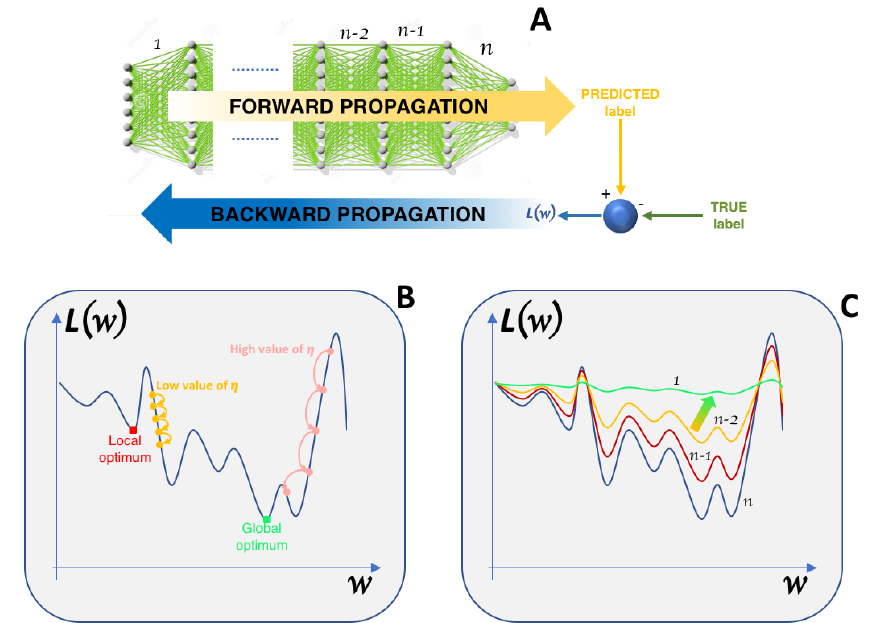
Figure 5. The Loss function and the backward propagating of its gradient. ( A ) The predicted label is compared with the true label for the current set of model weights θ w to compute the output error (also called a loss function) L ( θ w ) . ( B ) The learning rate η is used to jump over valleys. If the learning rate is too low (little jump), it may take forever to converge with a high risk of jamming in a local optimum. Conversely, a too high value (big jump) can cause a non-convergence of the learning algorithm. ( C ) For deep architectures, the magnitude of the back propagated error derivative decreases rapidly along the layers, resulting in slight update of the weights in the first